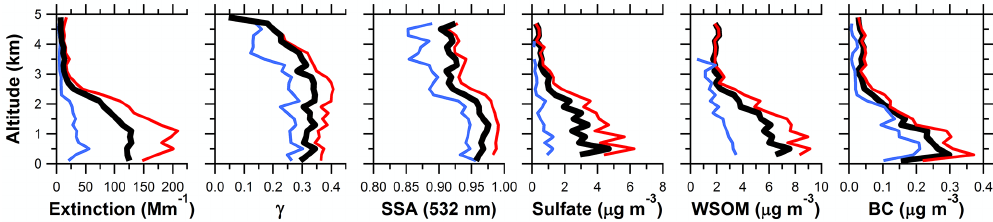
Figure 7. Average profiles for extinction (at ambient RH and 532nm), γ , SSA, and composition for all flights (black line), days with predominantly westerly transport from the Ohio River Valley (red line), and days with northerly transport (blue line).